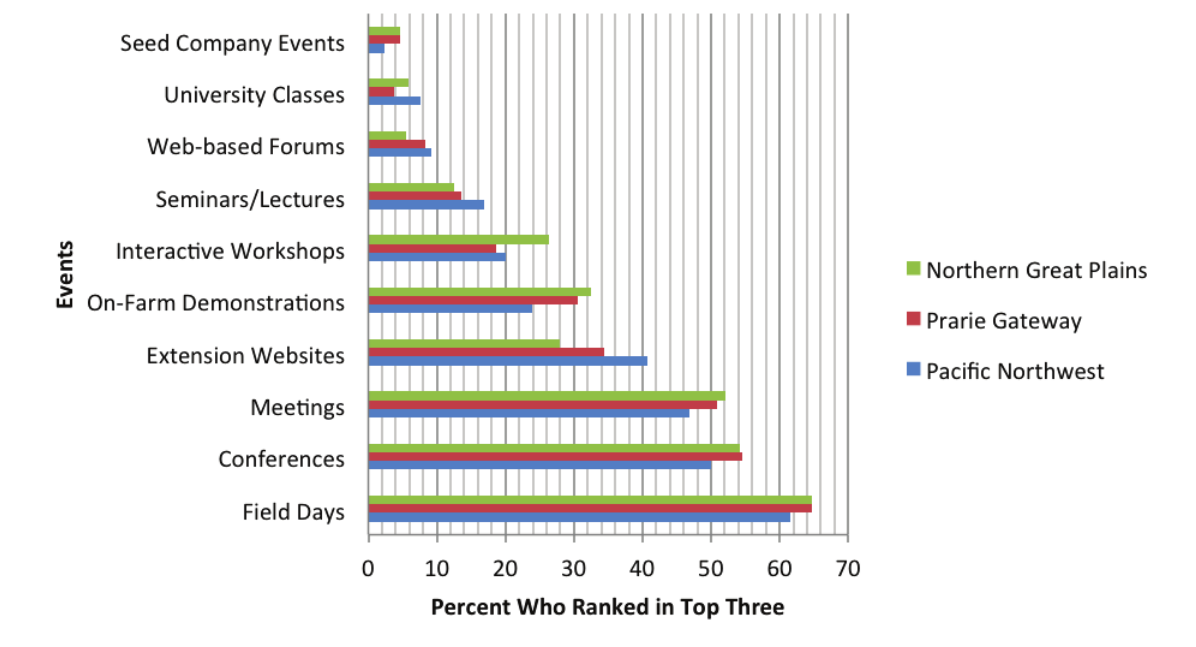
Figure 3: Events that extension educators and other outreach personnel ranked in the top three types they will likely attend to obtain crop and other agricultural production-related information. (Sample size for each region is: Pacific Northwest N = 130; Prairie Gateway N = 433; and Northern Great Plains N =